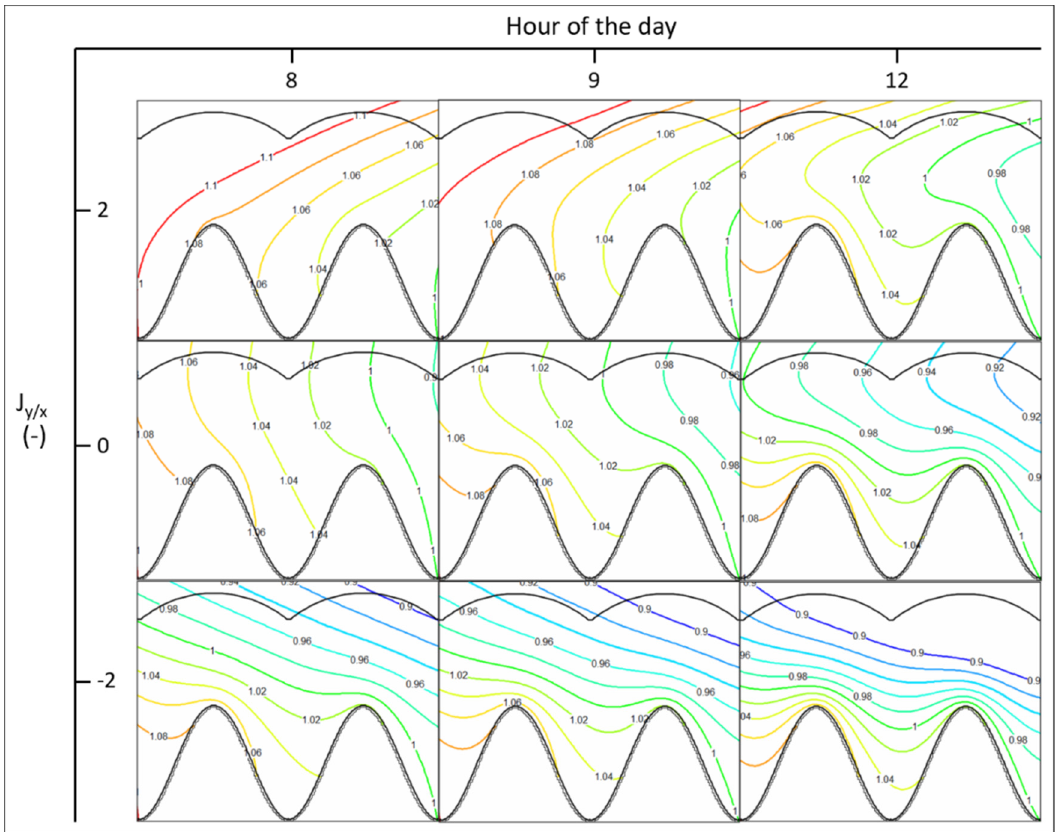
Figure 10. Snapshots of head (m) at different h of the day, as a function of regional groundwater flux ( J y/x ; positive for gaining, negative for losing) (rows). All snapshots came from simulations with ET max values of 80 mm/day. Table 3. Contour line orientations and average head gradients for all regional groundwater flux ( J y/ x ) scenarios at ET80. All delta values are 12th h conditions − 6th h conditions.